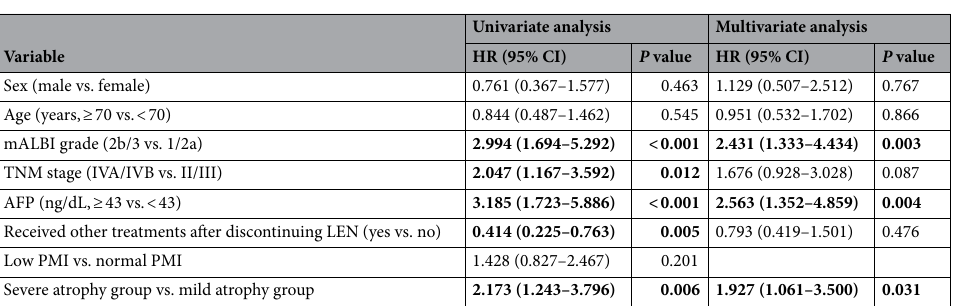
Table 3. Predictive factors for overall survival. Significant values are in [bold]. HR hazard ratio, CI confidence interval, mALBI modified albumin-bilirubin, TNM tumor node metastasis, AFP alpha fetoprotein, PIVKA-II protein induced by Vitamin K absence or antagonists-II, LEN Lenvatinib, PMI psoas muscle index. Low PMI group: PMI < 6.0 cm 2 /m 2 for men and < 3.4 cm 2 /m 2 for women, Normal PMI group: PMI ≥ 6.0 cm 2 /m 2 for men and ≥ 3.4 cm 2 /m 2 for women. Severe atrophy group: ΔPMI/m rate ≥ 1%, Mild atrophy group: ΔPMI/m rate < 1%. (ΔPMI/m rate: rate of change in psoas muscle index per month during administration of LEN).